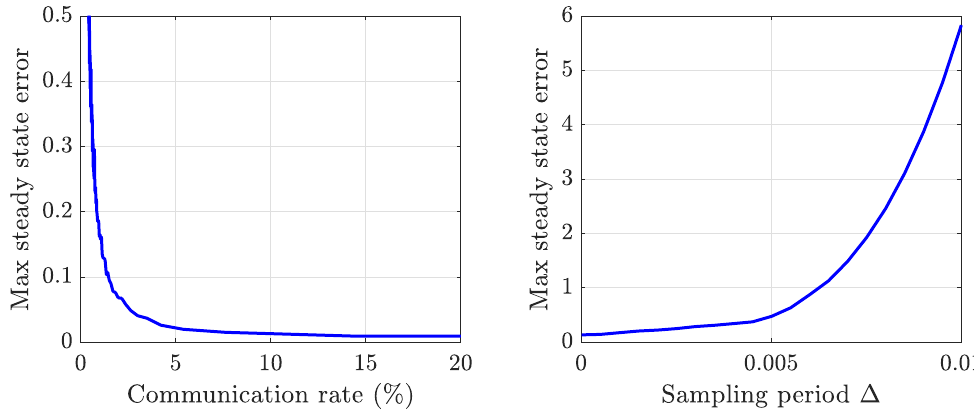
Figure 7. Trade-off between the consensus error and the communication rate (with fixed ∆ = 10 − 4 ) and trade-off with the sampling period (with fixed ε = 0.01 ) . As the value of the triggering threshold ε increases, the communication through the network is reduced, at the cost of a higher consensus error. However, using the event-triggering mechanism, communication can be significantly reduced with respect to the full communication case (communication rate of 100%), with a relatively small increase in the steady-state error. The consensus error also increases with the sampling period ∆